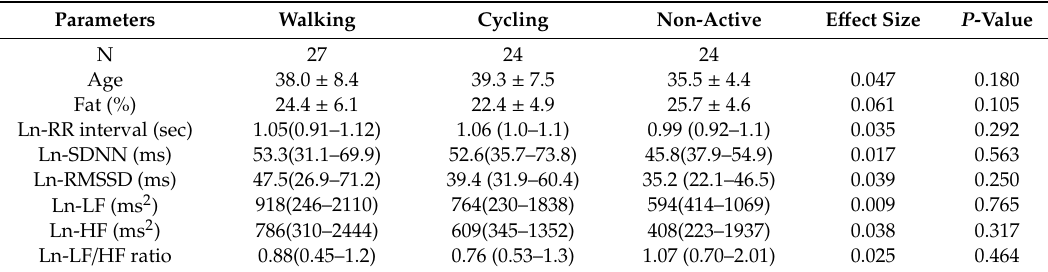
Table 1. Comparison between physical activity types (walking, cycling, non-active control) for time- and frequency-domain